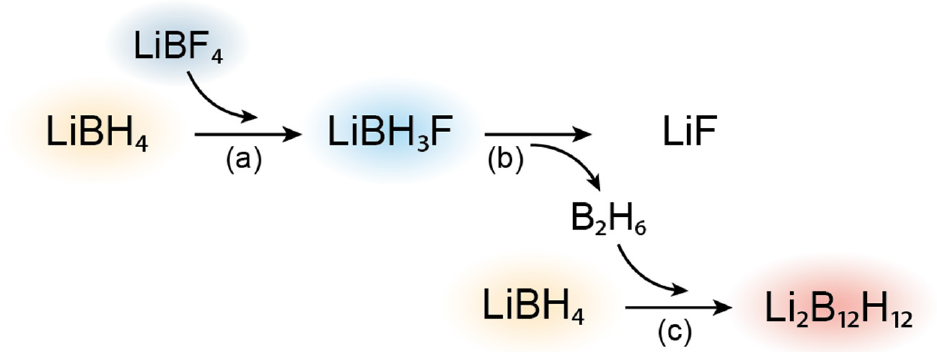
Figure 2. Reaction overview for LiBH 4 -LiBF 4 solid solutions as proposed by Richter et al. [36]. ( a ) Hydrogen-fluorine exchange of LiBF 4 with LiBH 4 to form LiBH 3 F. ( b ) Decomposition of the substituted material yielding LiF and B 2 H 6 . ( c ) Reaction of B 2 H 6 with excess LiBH 4 forming Li 2 B 12 H 12 . Reaction stoichiometry not taken in account in this overview.